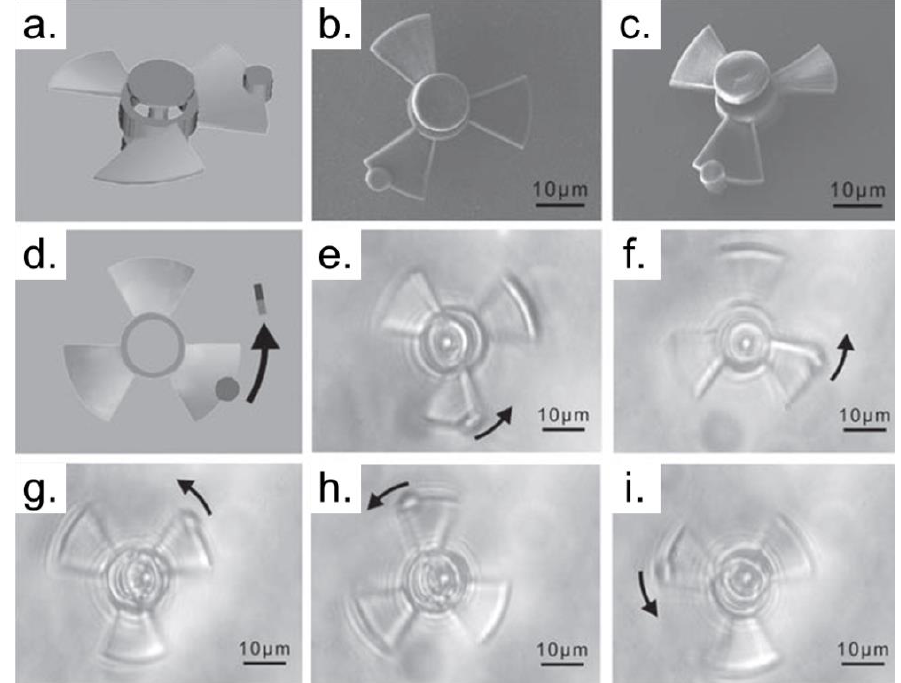
Figure 10. Remote control of the micro-turbine in acetone. ( a ) Model of the micro-turbine. ( b ) and ( c ) SEM images of the micro-turbine. ( d ) Top view scheme model for circumgyration. ( e – i ) Optical microscopy images of the microturbine in a circumgyration cycle. For remote control and observation of the micro-turbine, a piece of ferromagnet was placed on a vortical device around the objective lens. Reproduced with permission [93]. Copyright © 2010, John Wiley and Sons.